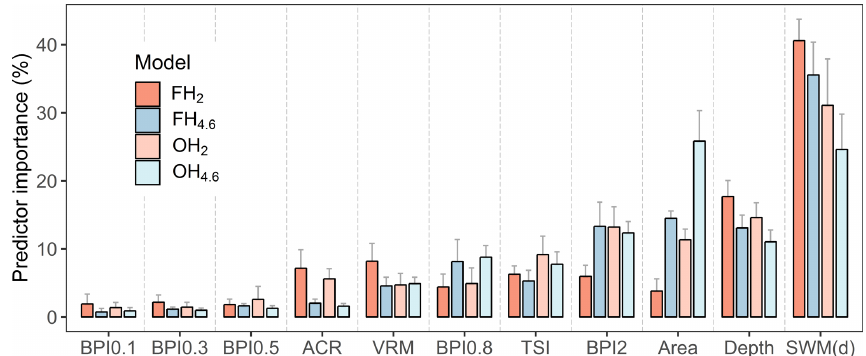
Figure 4. Importance of predictors based on 10 prediction rounds. Predictors are color-coded based on models. FH 2 : frequent, severe hypoxia (O 2 <2mgL − 1 ); FH 4 . 6 : frequent, moderate hypoxia (O 2 <4.6mgL − 1 ); OH 2 : occasional, severe hypoxia (O 2 <2mgL − 1 ),